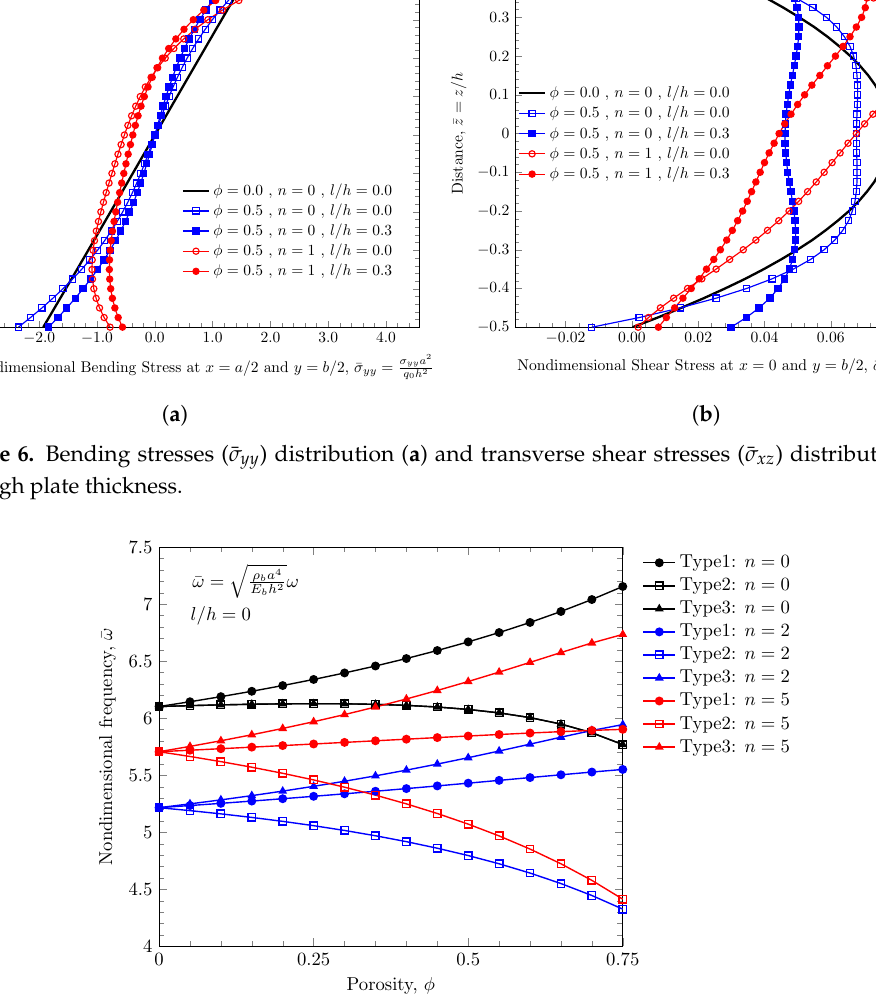
Figure 7. Non-dimensional fundamental frequency, ¯ ω versus porosity values, φ with zero length scale parameter l / h =